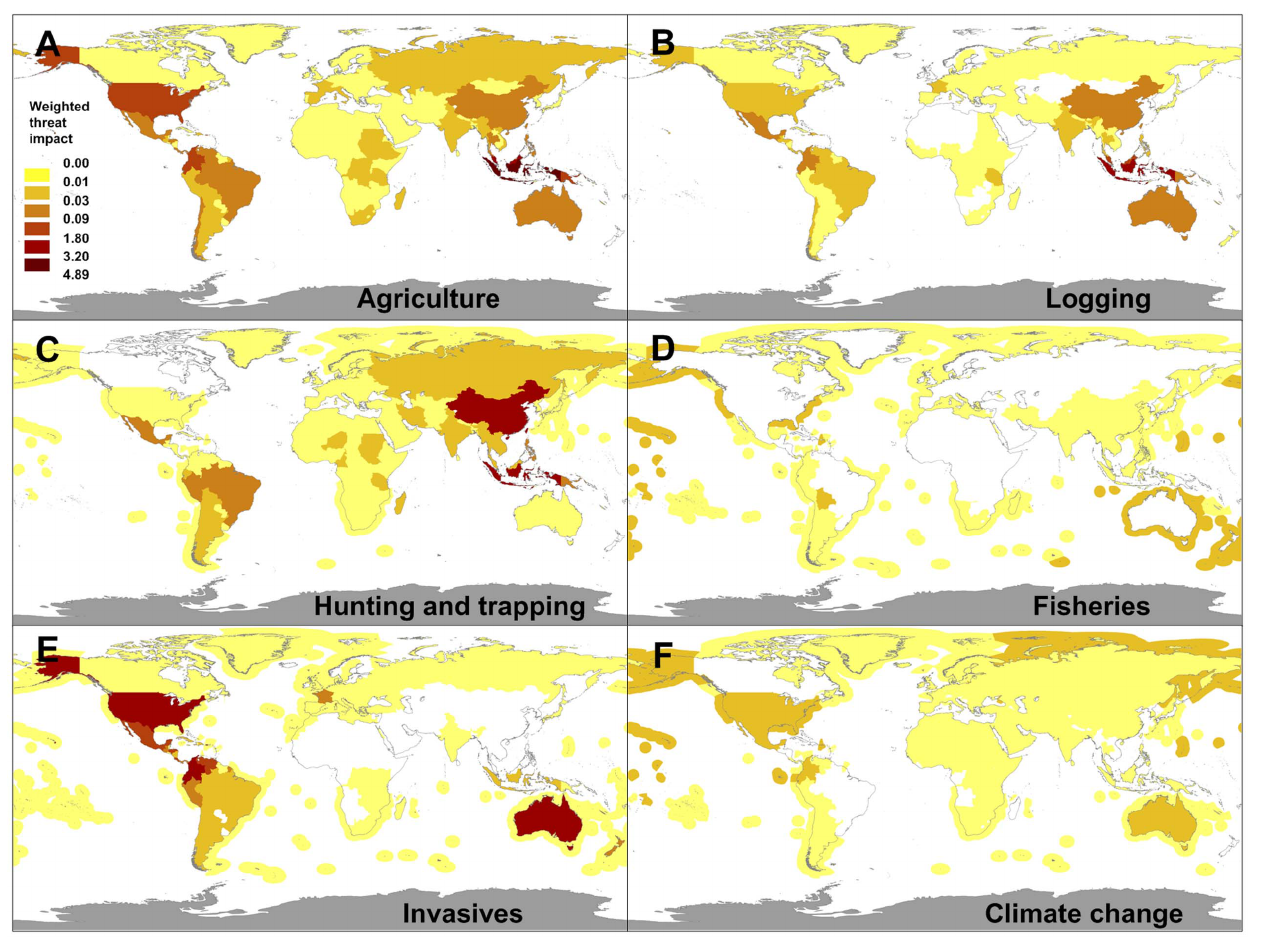
Figure 3. Contribution per country of different threats to the trends in the global conservation status of vertebrates. Mapped as the weighted impact of each threat type to the deterioration in global species conservation status, across countries. The same color scale is used across panels, hence shades are directly